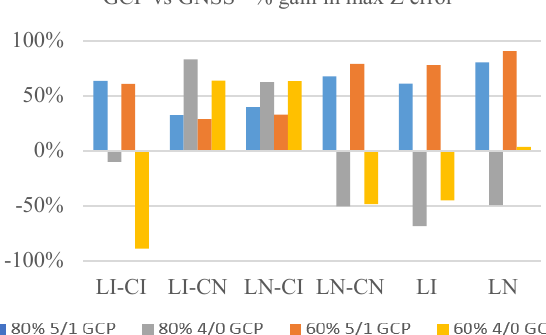
Figure 7. GCP vs GNSS max Z error gain for each of the six basic configurations and side-lap percentage. Positive values imply GNSS smaller errors, negative ones the contrary.